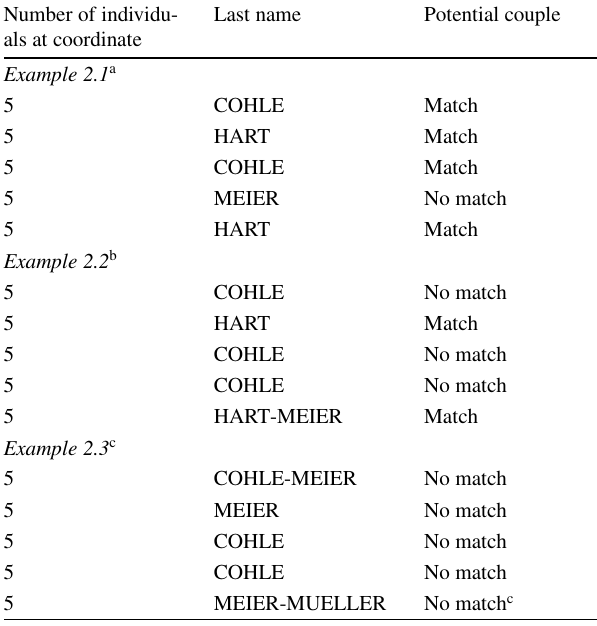
Table 2 Examples of the name-matching procedure Number of individu- als at coordinate